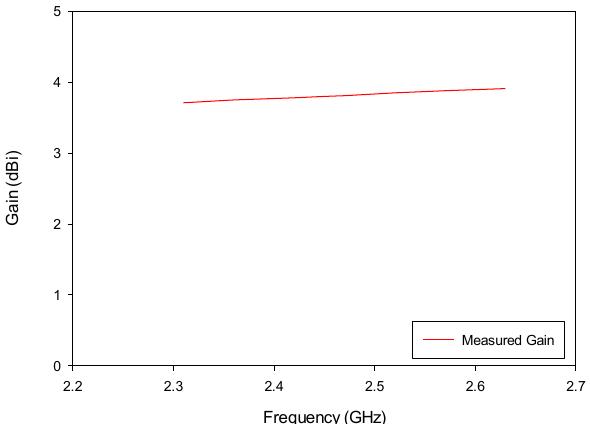
Figure 6: Gain of the proposed slot antenna loaded with rotated square SRR with